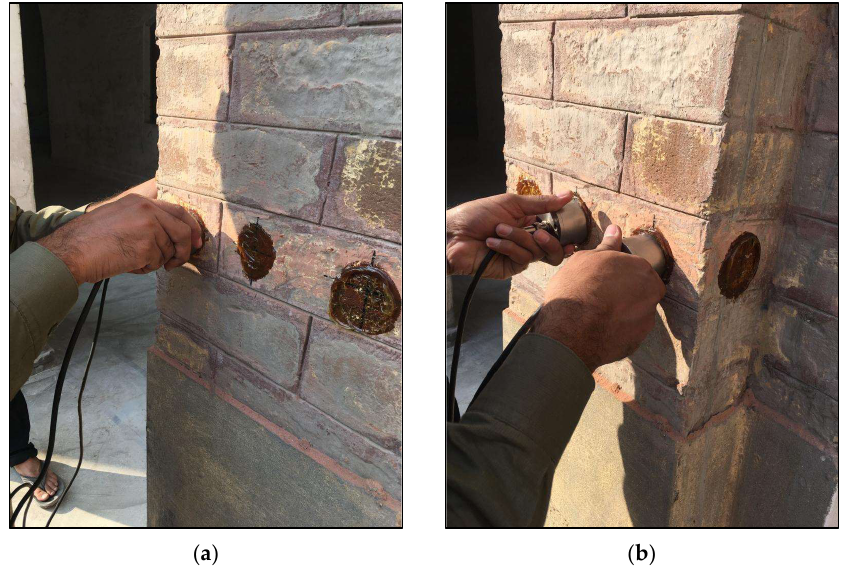
Figure 18. Performing in situ UPV test on Umar Hall building. ( a ) Semi-direct transmission, ( b ) indirect transmission.